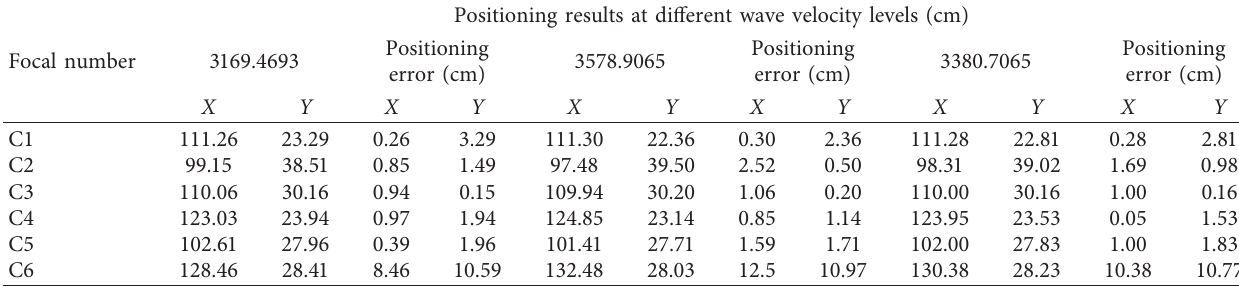
Table 15: Source location results for Scheme I of G3761-L.